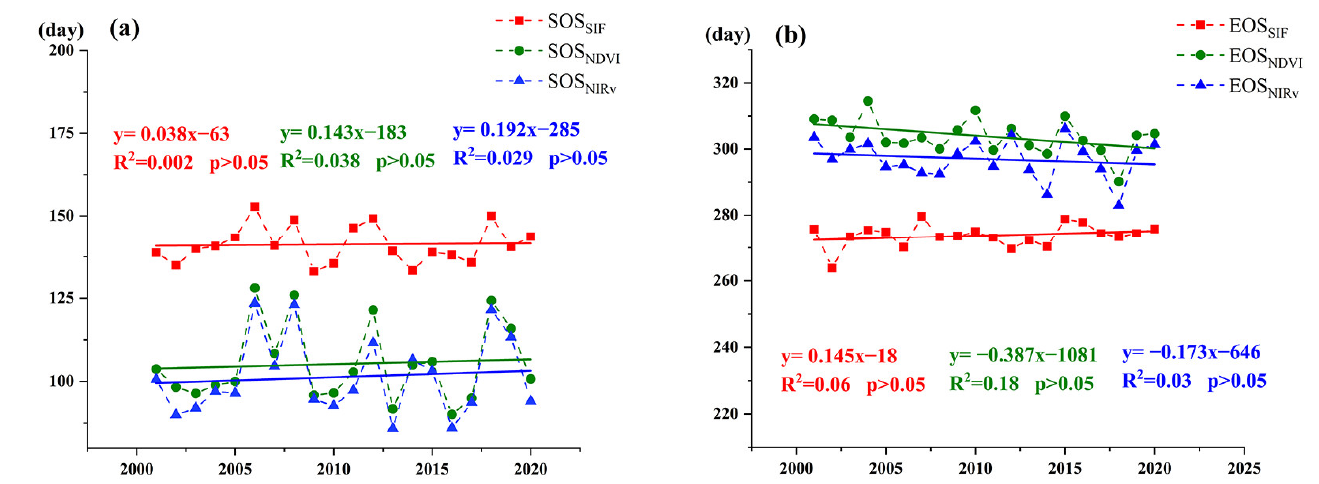
Figure 3. Temporal variation in phenological parameters of the three vegetation types on the Mon- golian Plateau, over 20 years; ( a ) is the linear trend of the three SOS; ( b ) is the linear trend of the three